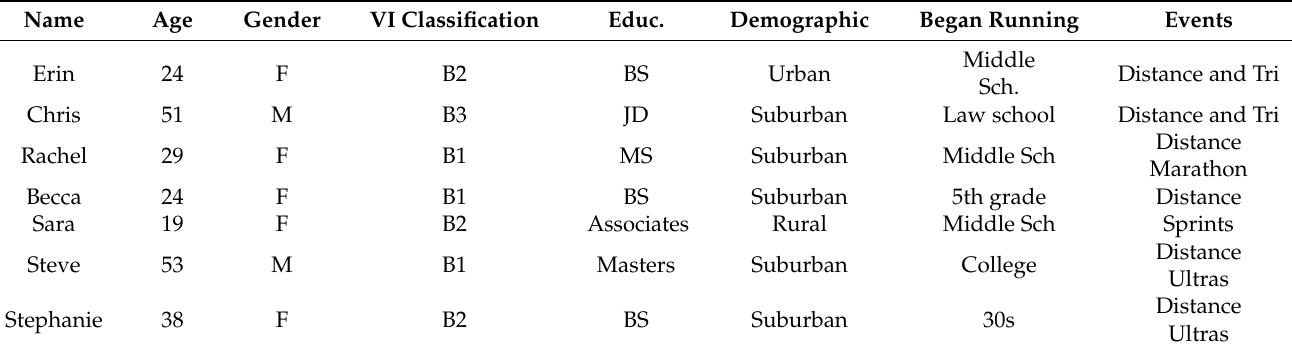
Table 1. 0 Demographic information of the runners.